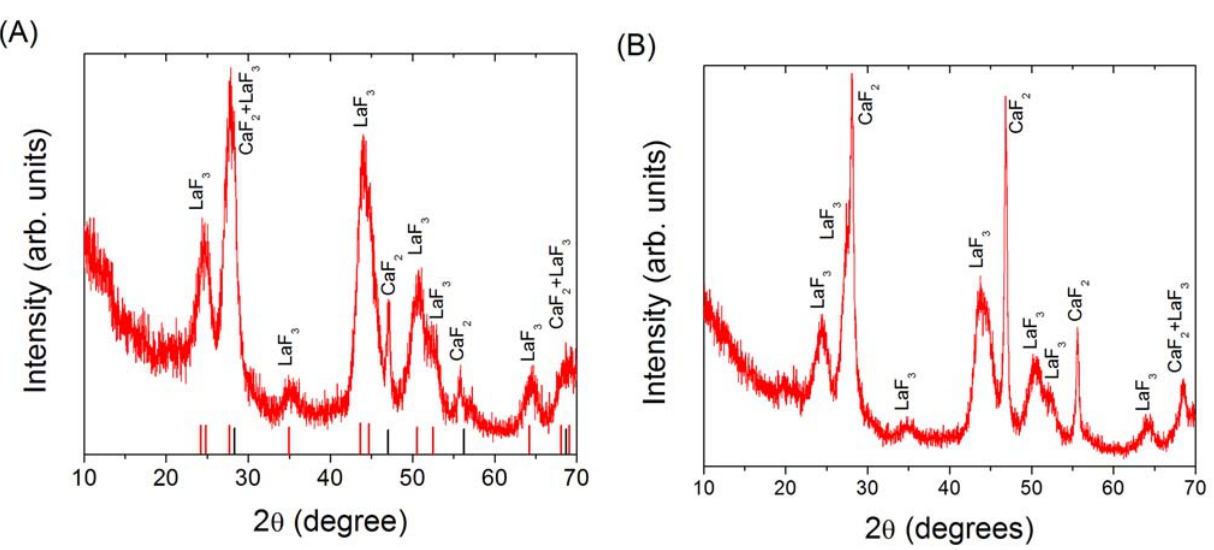
:Eu/CaF nanoparticles under 2 2